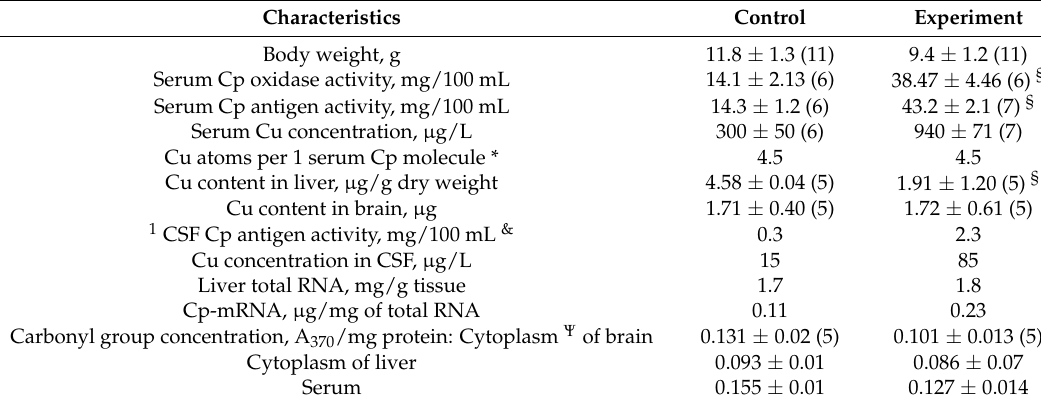
Table 4. The effect of baby formula feeding on the copper metabolism of 9-day-old